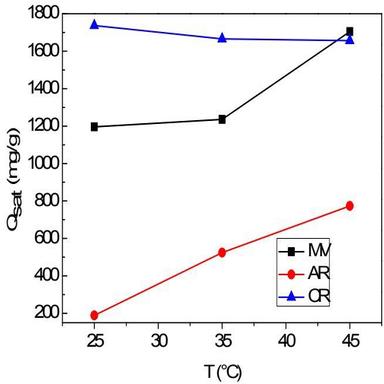
Influence of temperature on the dye adsorption capacity of activated carbon CMCAC at 25–45 ◦C.